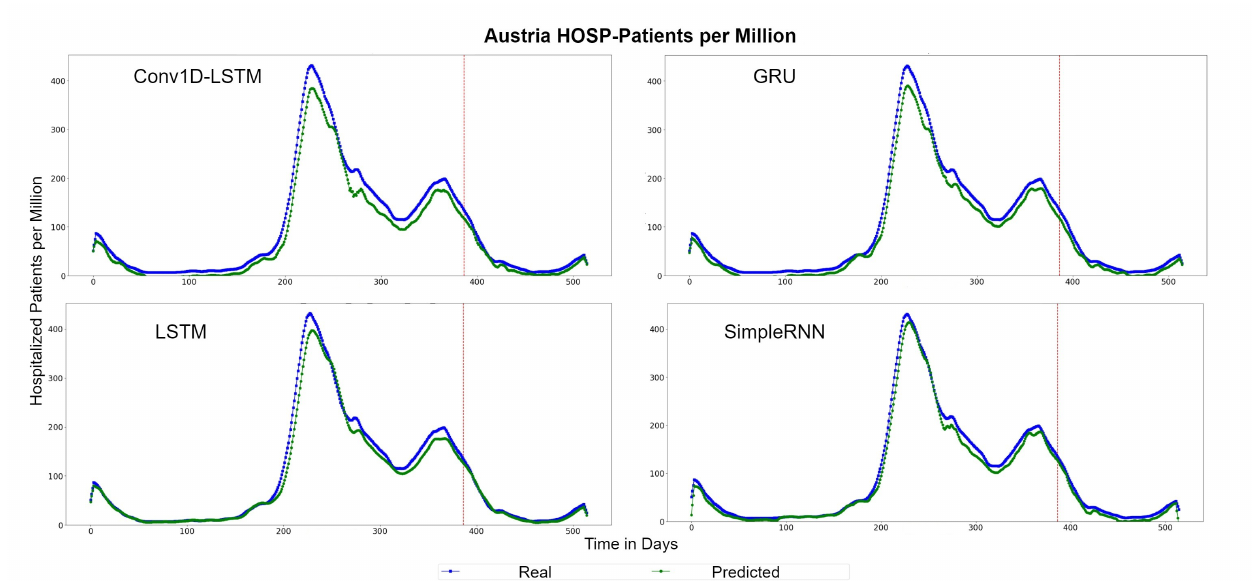
Figure 18. Austria’s HOSP-Patients per million real (blue line) and predicted (green line) values for each method, using the training, validation, and test datasets. The red line divides the train-validation (right size) and the test (left side) datasets.